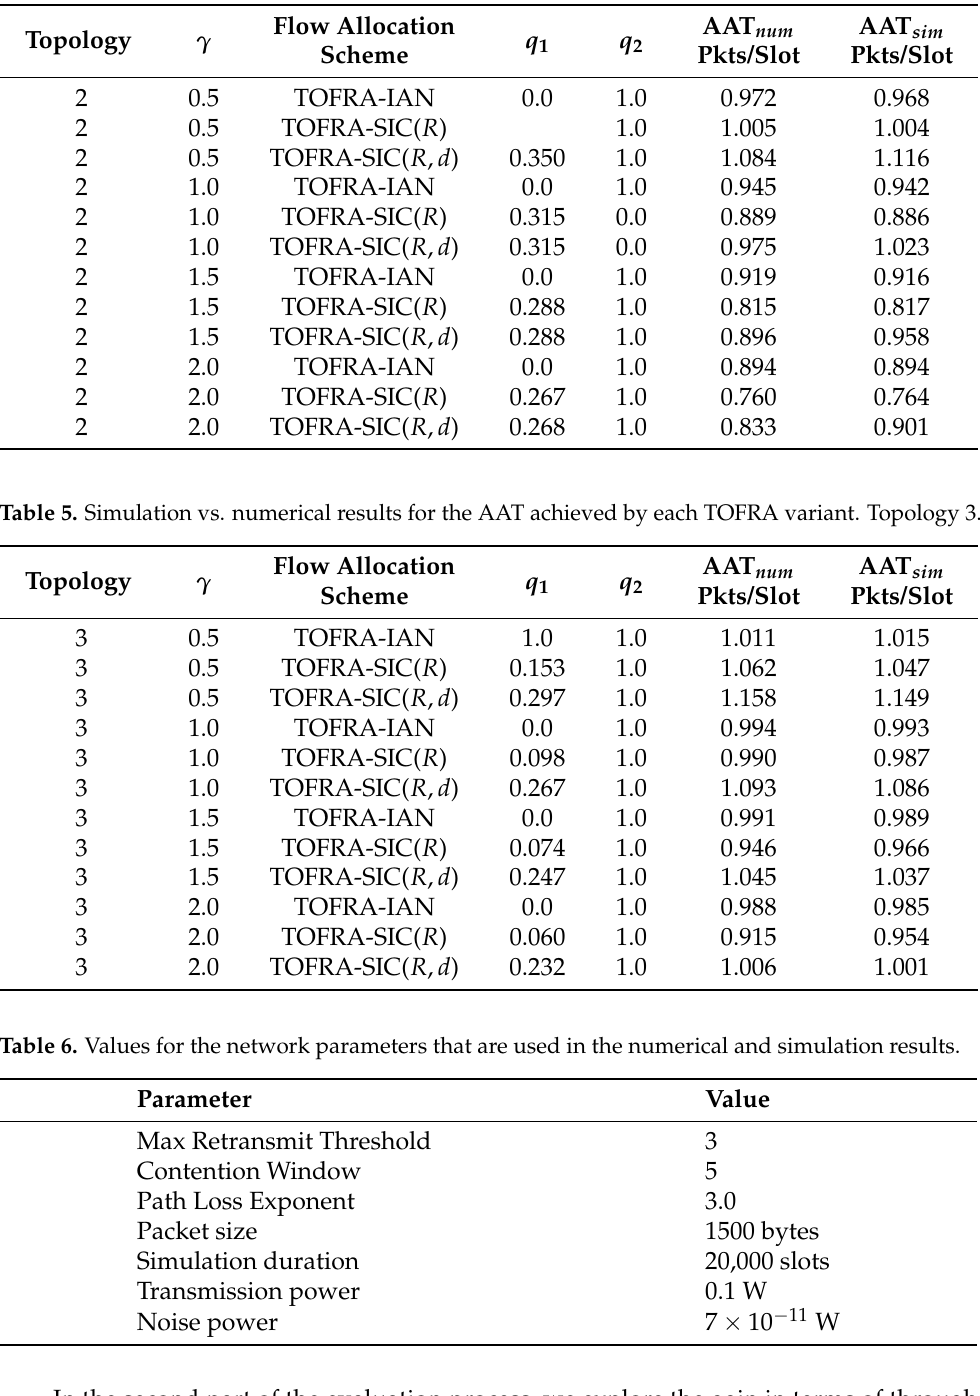
Table 4. Simulation vs. numerical results for the AAT achieved by each TOFRA variant. Topology 2.